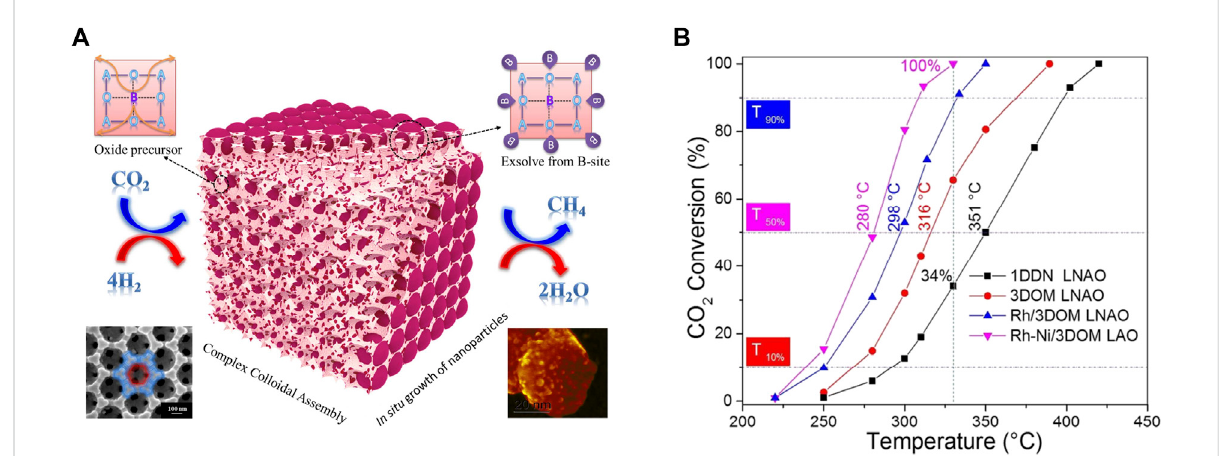
FIGURE 7 Schematicillustration of insitu exsolution ofthecatalyst froman ABO 3 perovskite structure (A) , and catalytic activitiesfor thedifferentcatalysts (B) . Reproduced from Arandiyan et al. (2018); Copyright © 2018 (American Chemical Society).